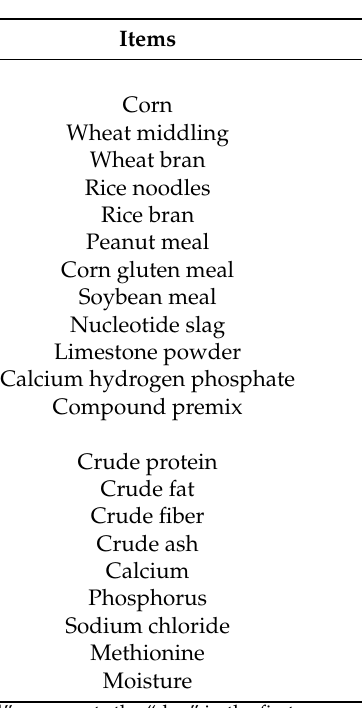
Table 1. Table of nutritional value of feed in each